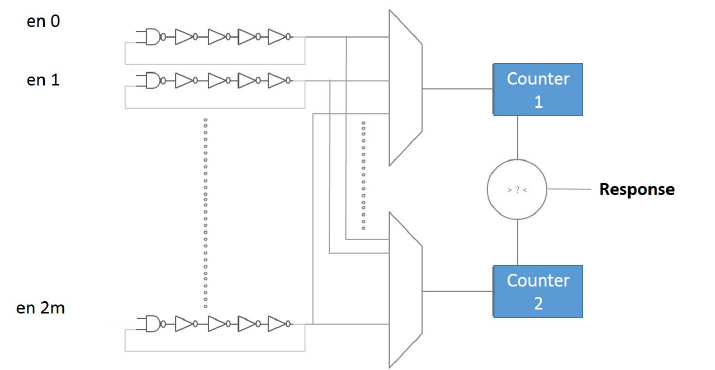
Figure 5. Ring oscillator architecture. Adapted from